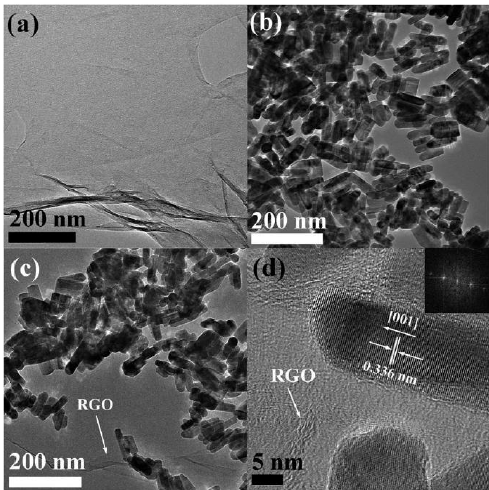
Figure 10. TEM images of pure GO ( a ) and pure CdS nanorods ( b ). TEM ( c ) and HRTEM ( d ) images of RGO-CdS nanorods composites. Reproduced from Ref. [58]. Copyright 2014 with permission from The Royal Society of Chemistry.